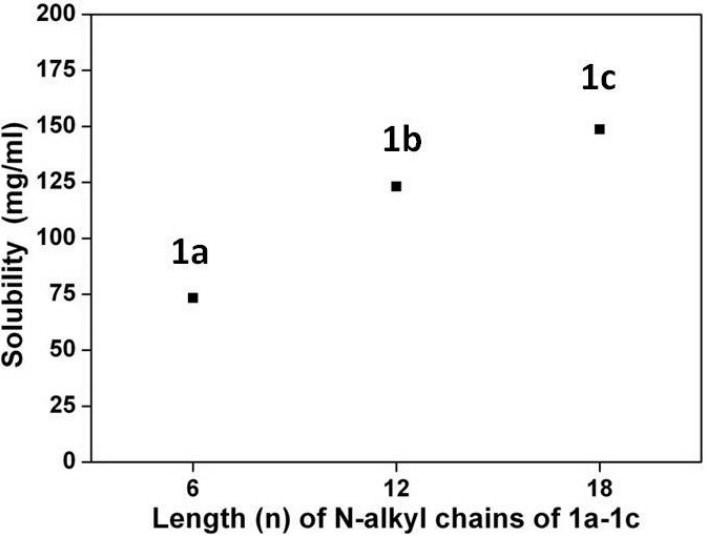
Figure 1. Solubility of 1a – 1c in dichloromethane (25